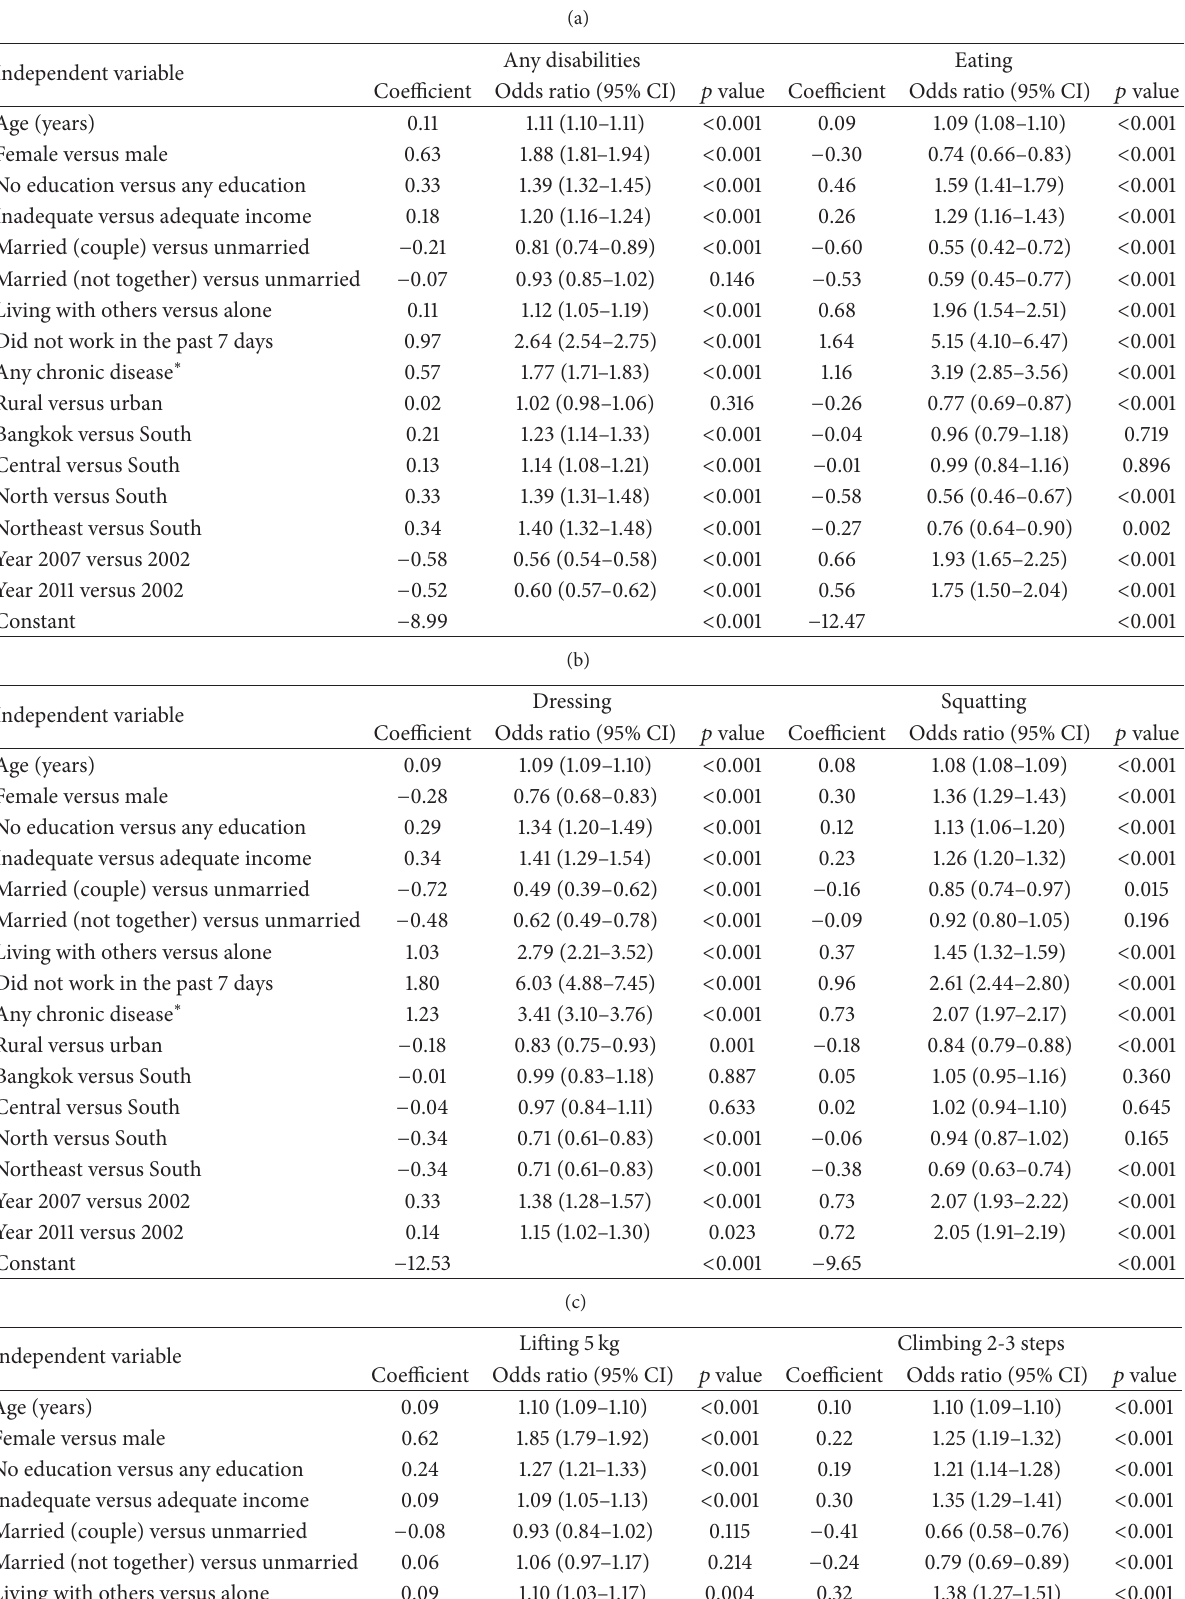
Table 4: Logistic regression over all three years (sample probability